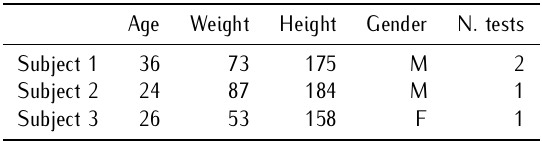
Table 2. Experimental protocol used for capturing data on the treadmill. Each checked cell represents a test composed of five minutes of recovery time plus five minutes of activity. Unchecked cells represent tests that were dangerous or too difficult